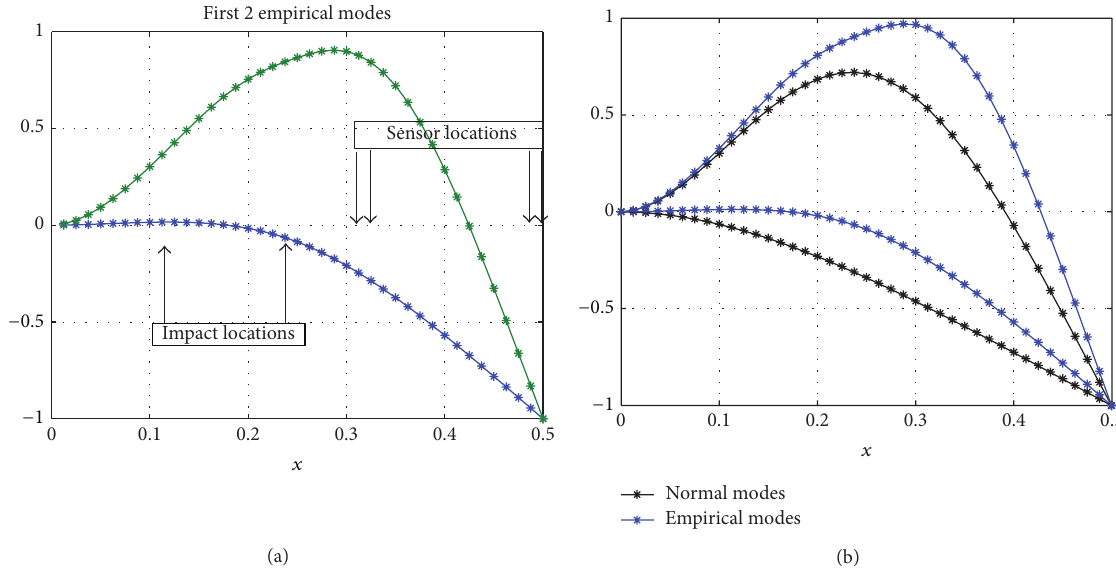
Figure 6: (a) First two proper orthogonal modes of the nonlinear system with the corresponding impact locations; (b) proper orthogonal × normal modes.